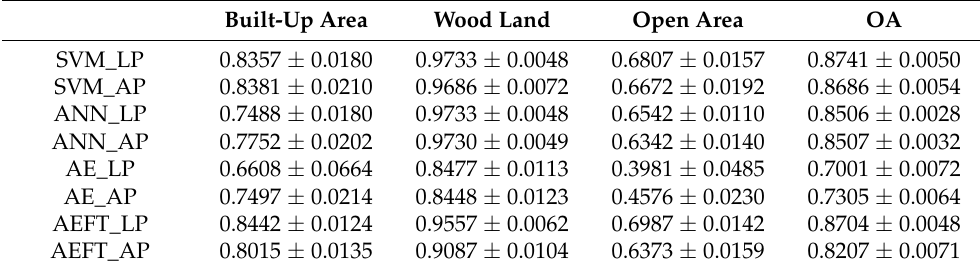
Table 12. Objective evaluation indicators of four classifiers on the learned parameters and all parameters of Touzi decomposition for Oberpfaffenhofen image.